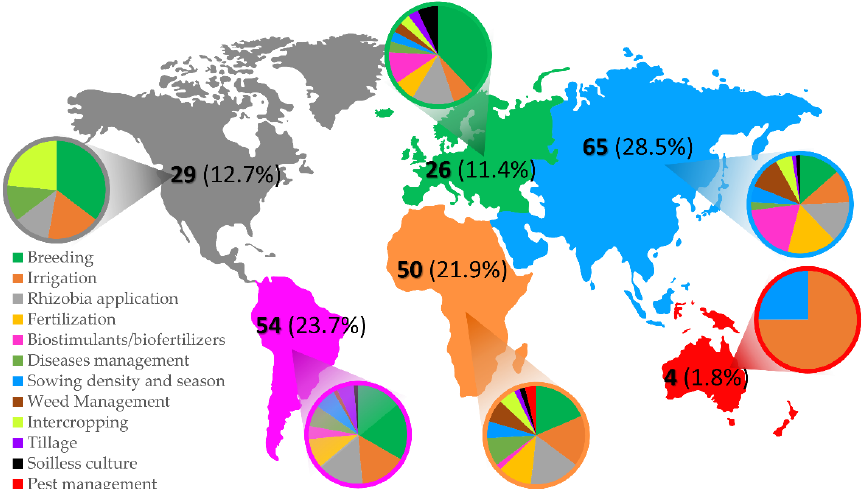
Figure 4. World map showing the number and the percentage (%) of publications per continent. The colour in each pie chart represents the % of publications for each category of agronomic practices (breeding, sowing density and season, irrigation, fertilization, intercropping, soilless culture, tillage, rhizobia application, biostimulant/biofertilizer application, disease management, pest management and weed management, respectively). (Basic map: © Copyright Showeet.com, last accessed on 22 December 2021).